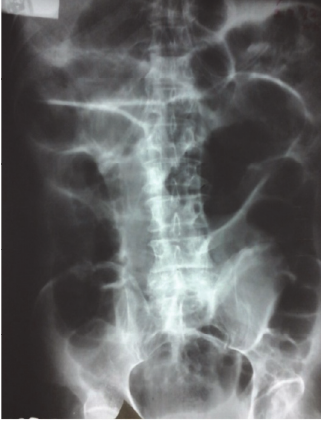
Figure 1: Supine X-ray abdomen showing dilated small bowel loops.